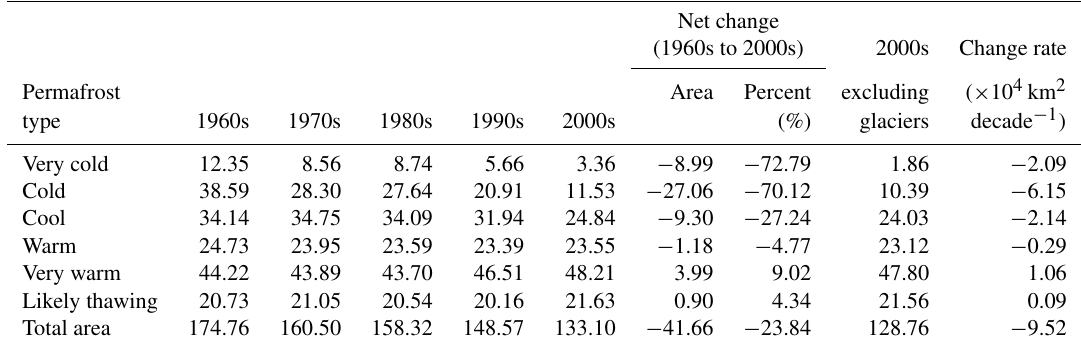
Table 3. The area statistics of the permafrost types over the QTP in the past 50years ( × 10 4 km 2 ). Net change (1960s to 2000s) 2000s Change rate Permafrost Area Percent excluding ( × 10 4 km 2 1960s 1970s 1980s 1990s 2000s (%)